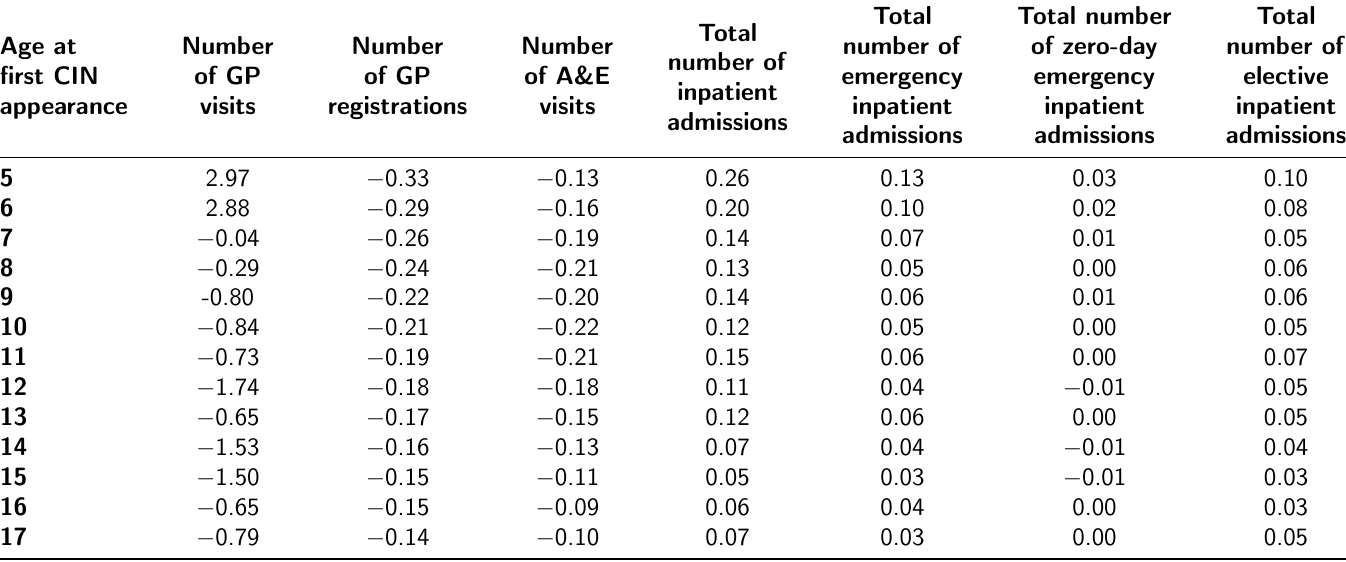
Table 3: Healthcare utilisation rate for children in need compared to population baseline. All columns are rates per year prior